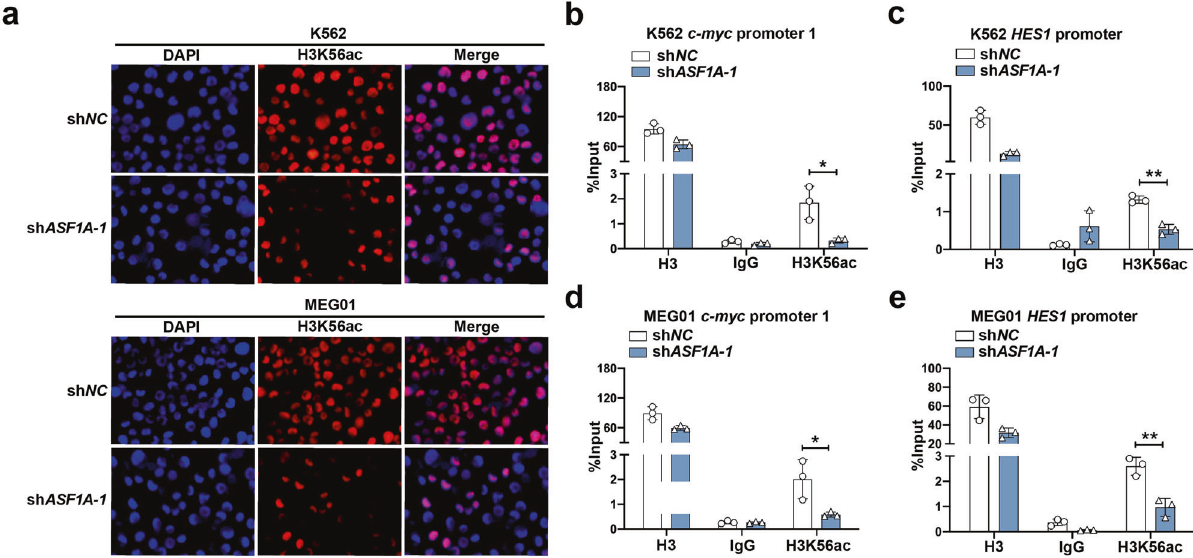
Fig. 6 ASF1A licenses H3K56ac modi fi cation in the promoter regions of Notch target genes. a IF staining of histone H3K56 acetylation in K562 and MEG01 cells expressing empty vector (sh NC ) or sh ASF1A-1 . b – e Enrichment of H3K56ac at c-Myc ( b , d ) and HES1 ( c , e ) promoters in K562 and MEG01 cells expressing empty vector (sh NC ) or sh ASF1A-1 . Histone H3 and IgG antibodies were used as positive and negative controls, respectively. Statistical signi fi cance was determined by Student ’ s t test. Data are shown as mean ± standard deviation (SD). Data are shown as a representative result with three repeats from three independent experiments. The cell lines are applied with three independent lentiviral infections in a – e . * P < 0.05, ** P <